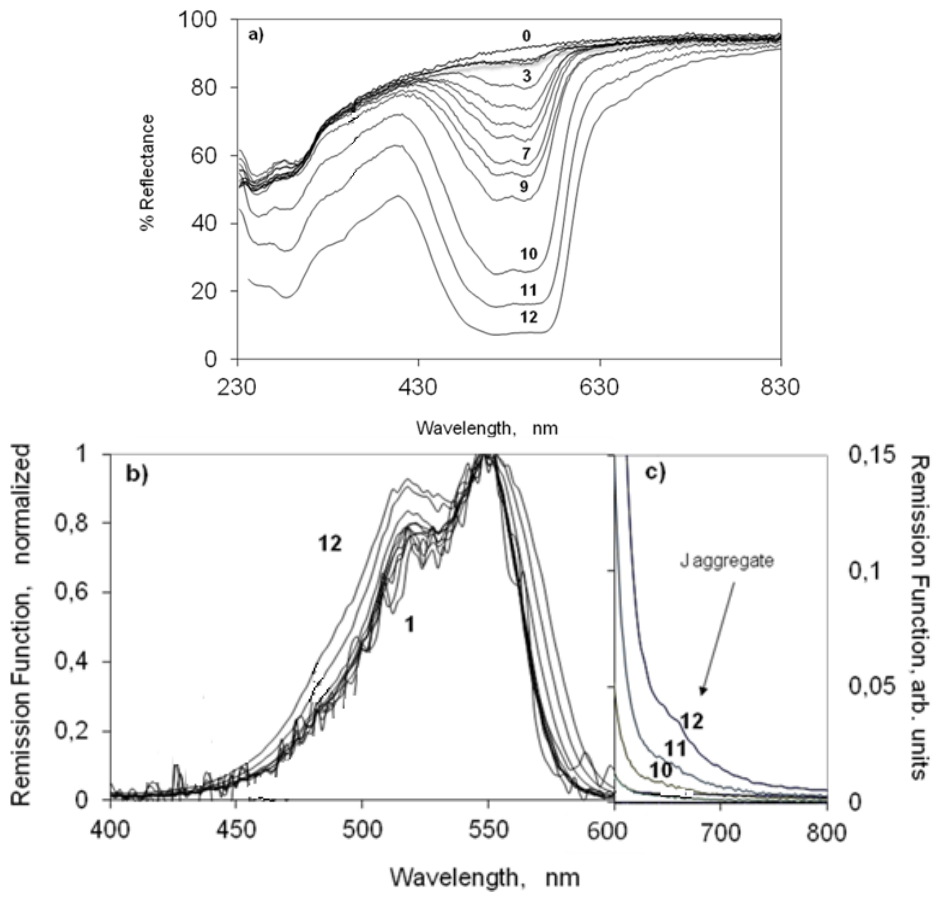
Figure 2. ( a ) Percentage Reflectance, ( b ) Remission function (normalized at the absorption maximum) and ( c ) Remission function of the 3,3'-di(2-sulfoethyl)-indocarbocyanine dye onto microcrystalline cellulose. The concentrations are (0) 0 (1) 0.001 (2) 0.01 (3) 0.05 (4) gram of microcrystalline cellulose. Curve marked in bold in part b is from the dye in